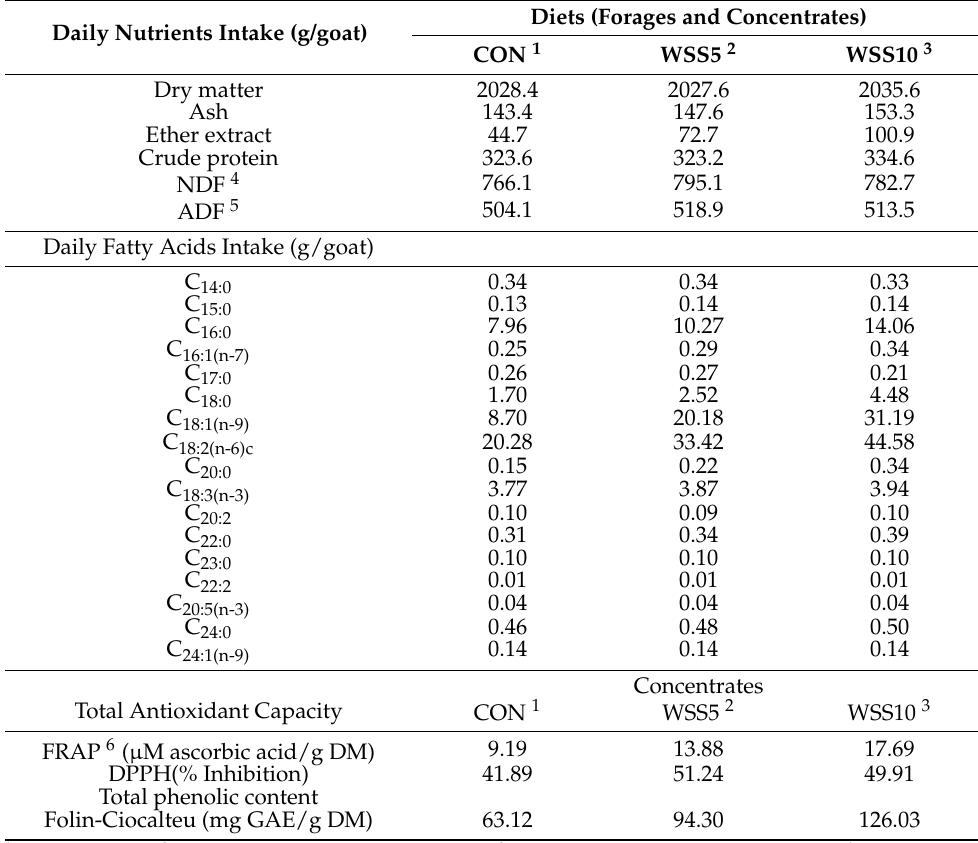
Table 1. Nutrients and fatty acids intake from forages and concentrates, and the total antioxidant capacity and phenolic content of concentrates only. Diets (Forages and Daily Nutrients Intake (g/goat)